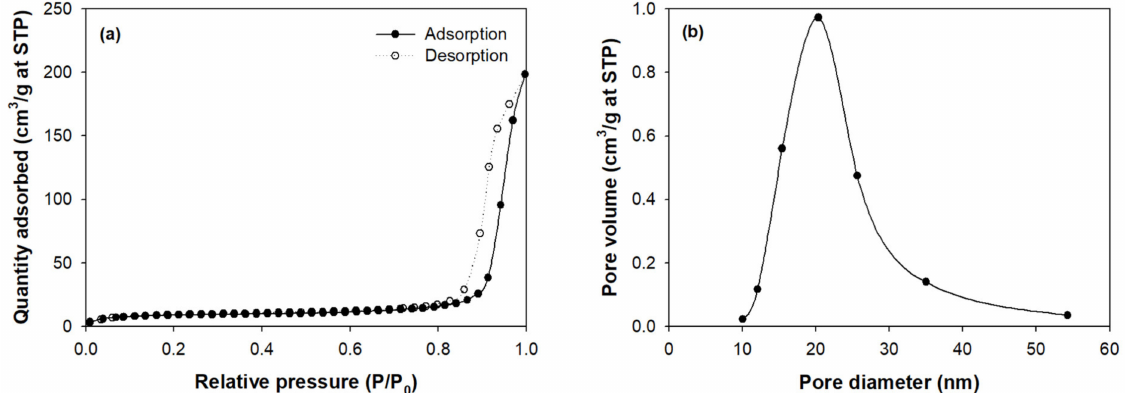
Figure 3. N 2 adsorption–desorption isotherms ( a ) and pore size distribution curves ( b ) of PEI/PVC-CF. (STP: standard temperature and